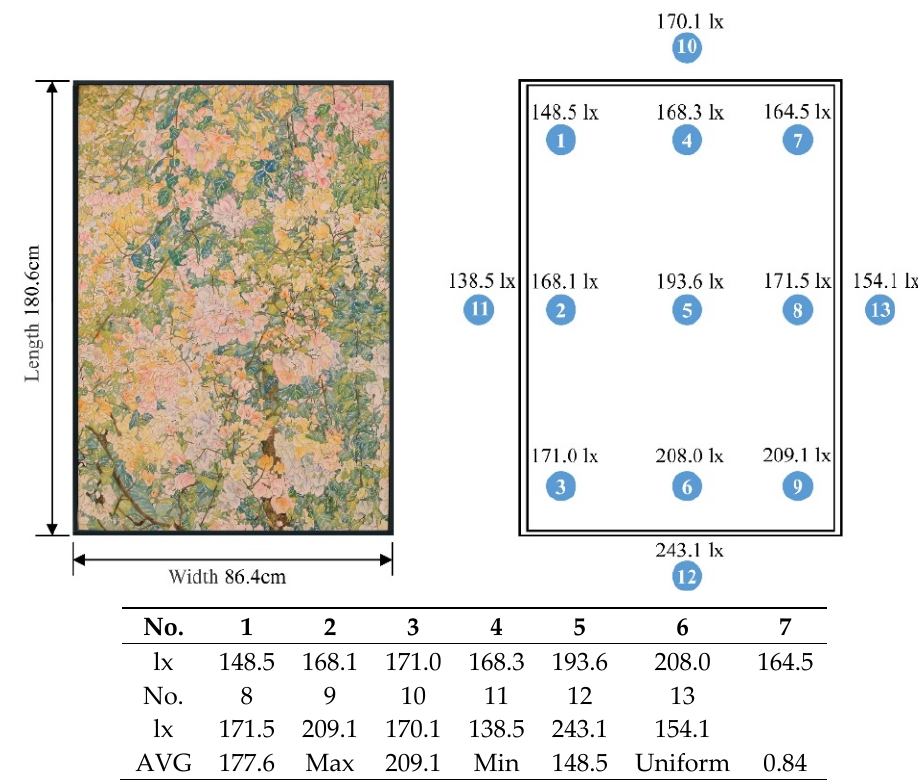
Figure 8. Illumination distribution test of oil painting and background wall in indirect lighting environment.